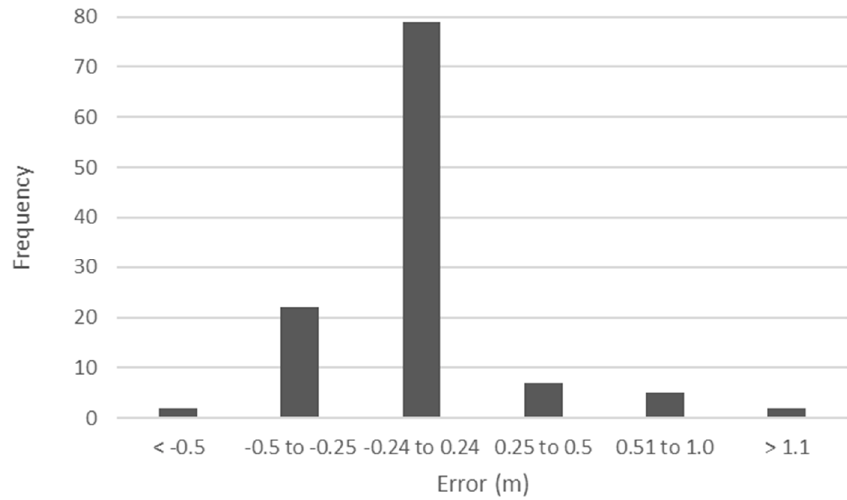
Figure 9. Frequency of error between measured and calculated water depth.